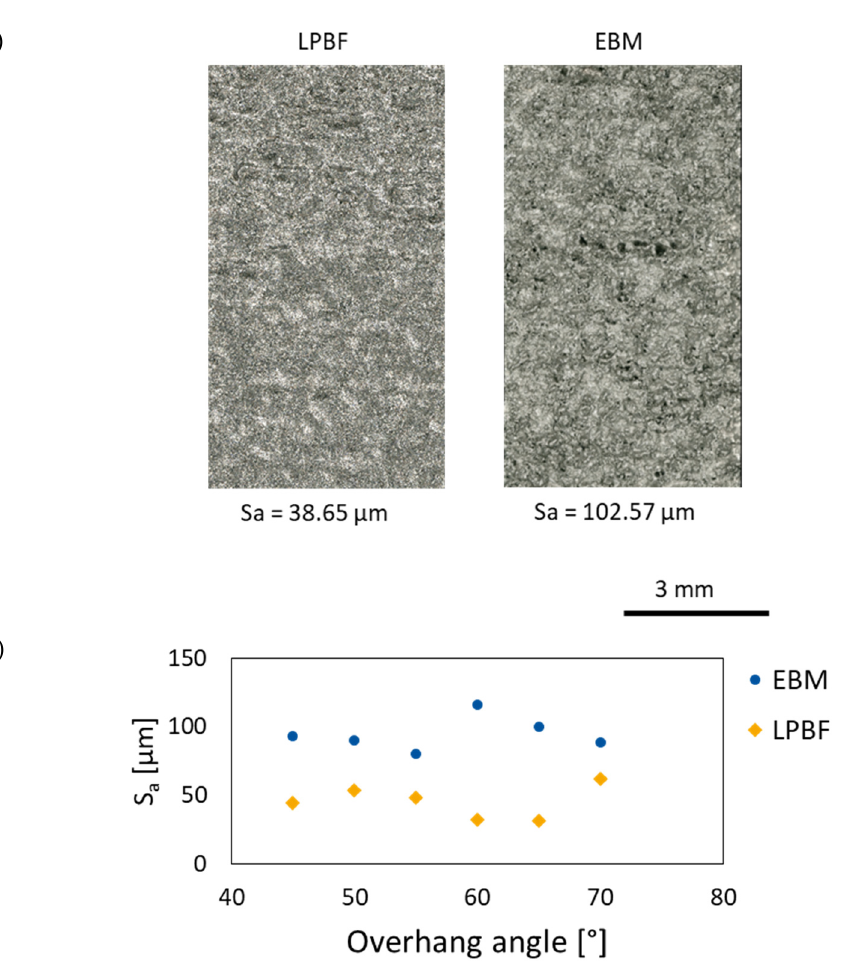
Figure 10. Surface roughness results of LPBF and EBM overhangs. ( a ) Microscope image of sand blasted LPBF and EBM overhangs. ( b ) Surface roughness plotted against overhang angle for LPBF and EBM.